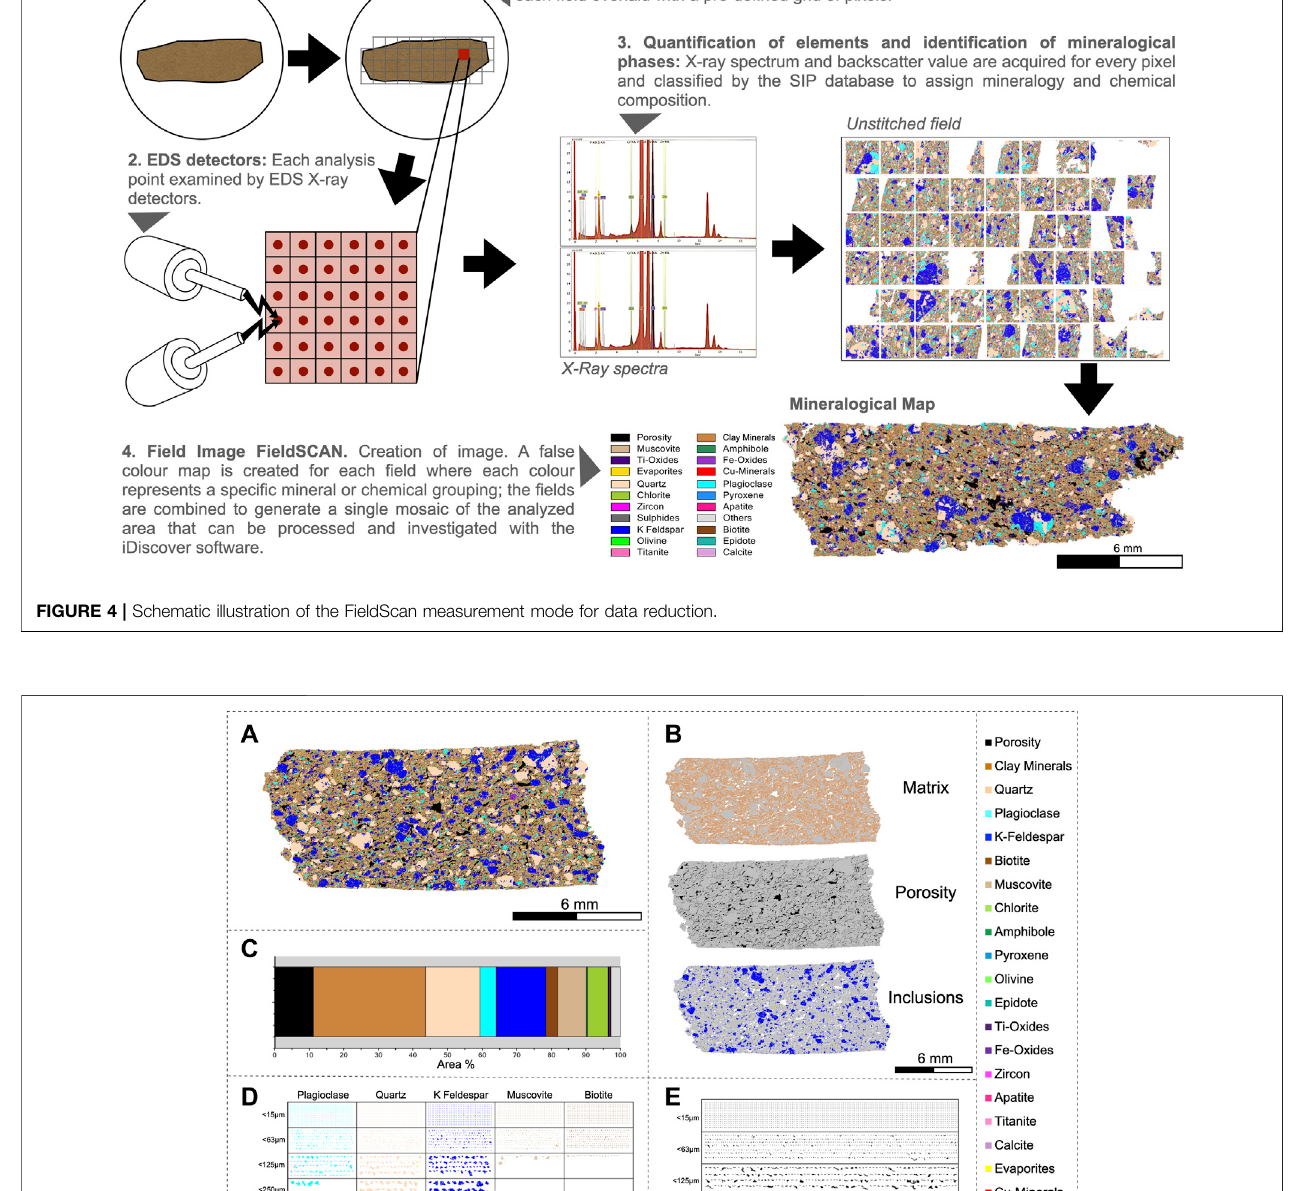
Frontiers in Earth Science |